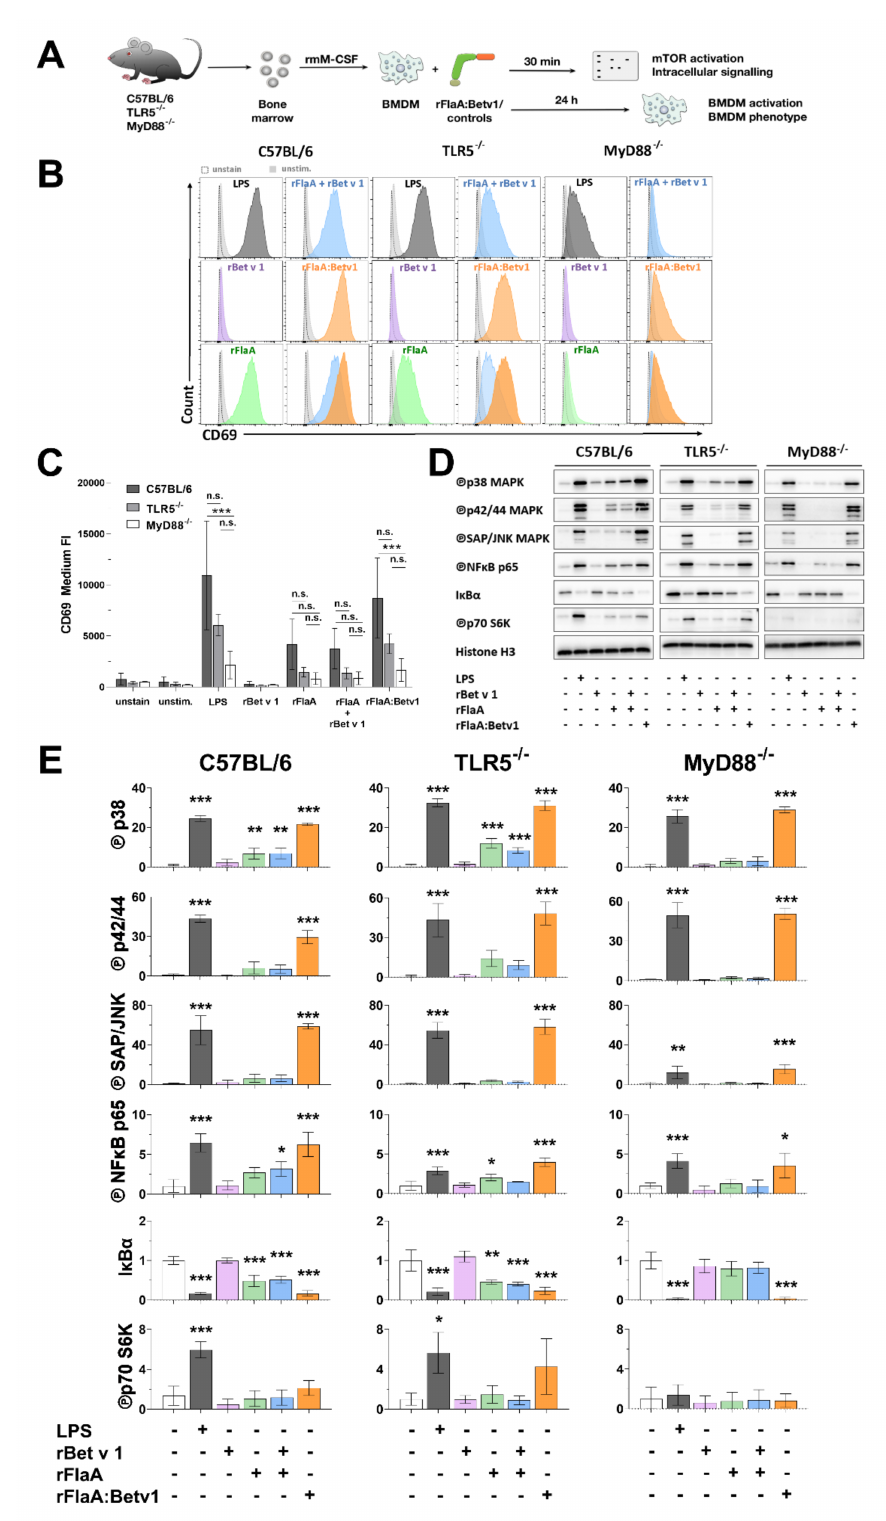
Figure 4. rFlaA:Betv1-stimulation induces stronger BMDM activation characterized by signaling of MAPK, NF κ B, and mTOR . C57BL/6, TLR5 − / − , or MyD88 − / − BMDMs were differentiated